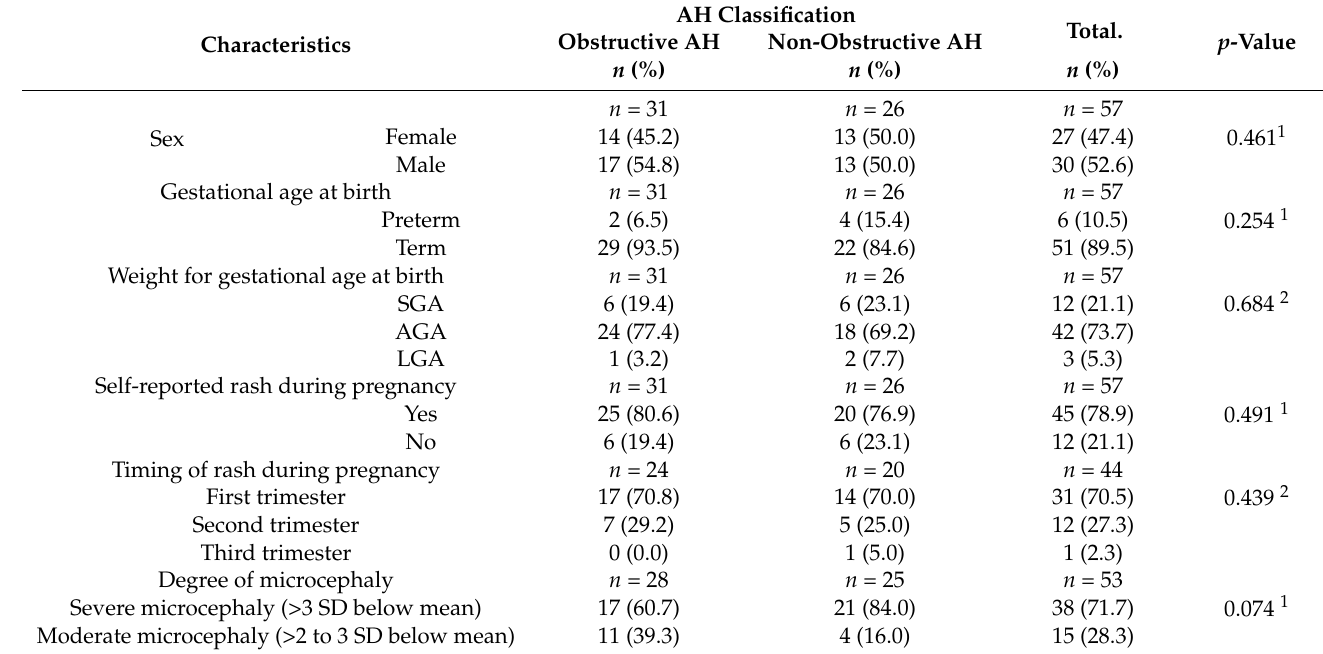
Table 1. Selected characteristics by adenoid hypertrophy (AH) status of infants with Zika-related microcephaly and symptoms of upper respiratory obstruction ( N =